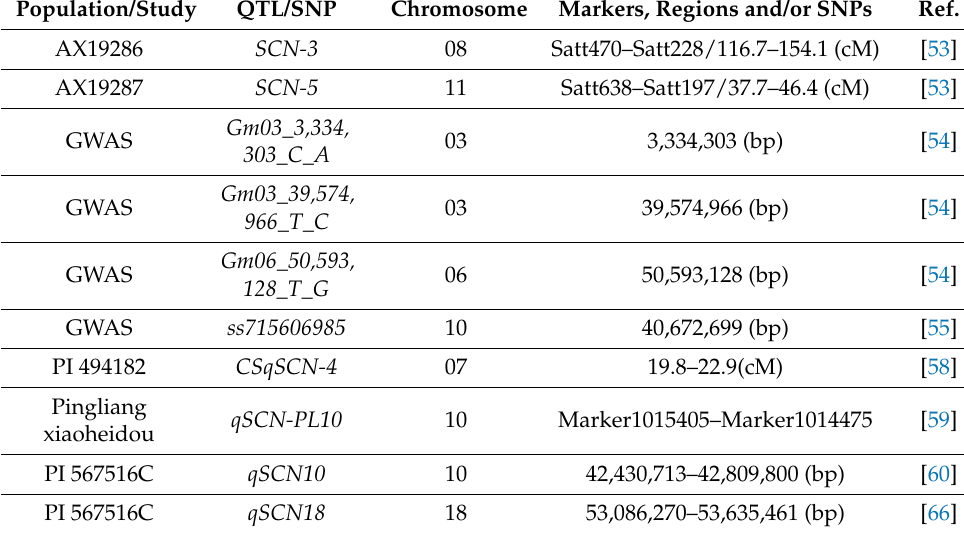
Table 1. Summary of novel sources of resistance QTL’s and SNPs from Section 4 of the review. Regions in base pairs (bp) are based on Wm82.a2.v1. For a more up to date and complete list of QTL’s and SNPs please refer to SoyBase https://www.soybase.org (21 January 2022). Population/Study QTL/SNP Chromosome Markers, Regions and/or SNPs Ref. AX19286 SCN-3 08 Satt470–Satt228/116.7–154.1